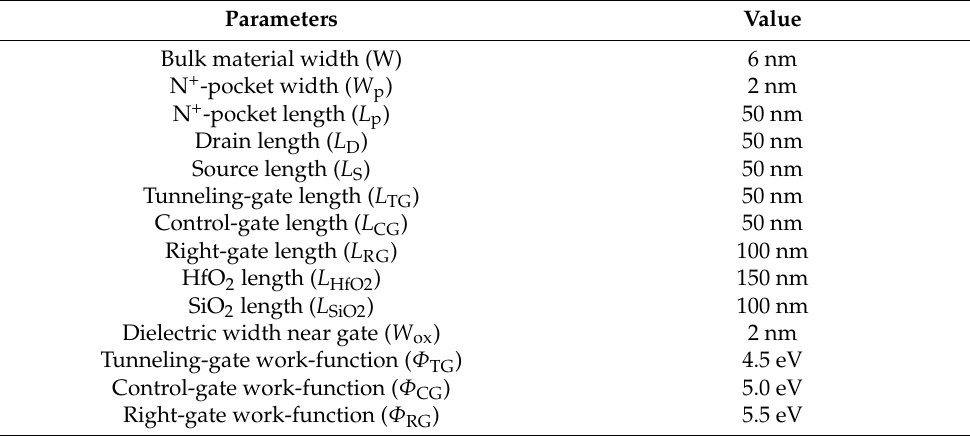
Table 1. Device structure parameters used in simulations.